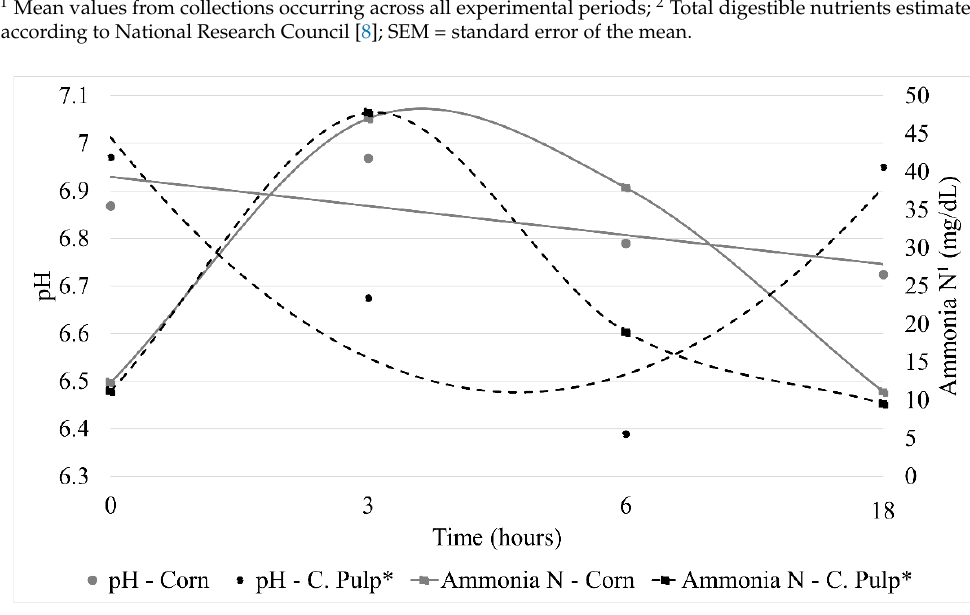
Table 4. Nitrogen balance, efficiency of microbial synthesis and blood urea nitrogen of rumen- cannulated Nellore steers grazing Uruchloa brizantha cv Marandu pastures and fed corn or citrus pulp-based supplements during the wet-dry transition period 1 . Treatment Component